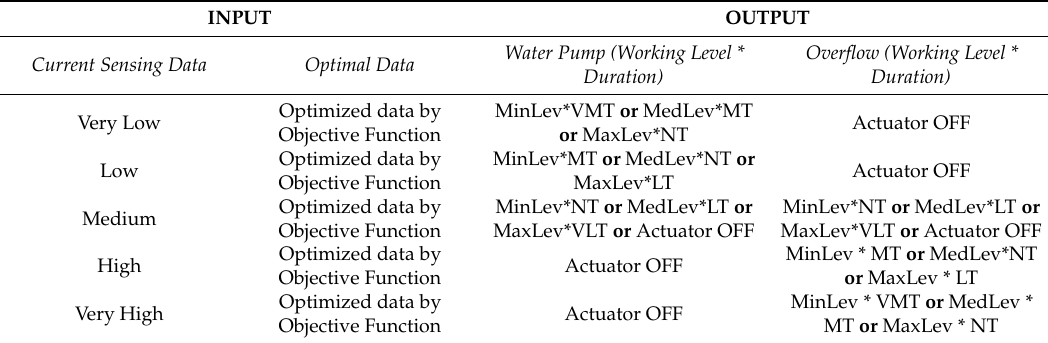
Table 3. Fuzzy associative matrix for the hydroponics in water level